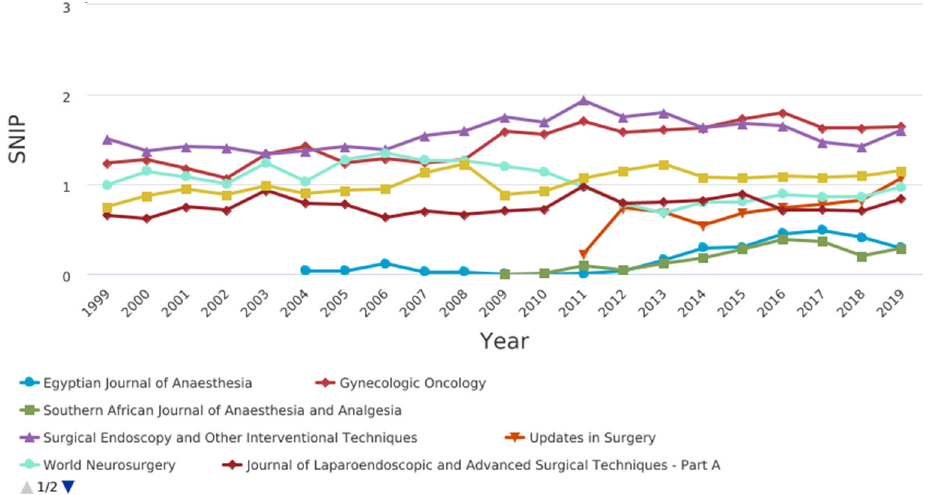
Figure 6. Source-normalized impact per paper (SNIP) of pain, anesthesia, and surgery journals.